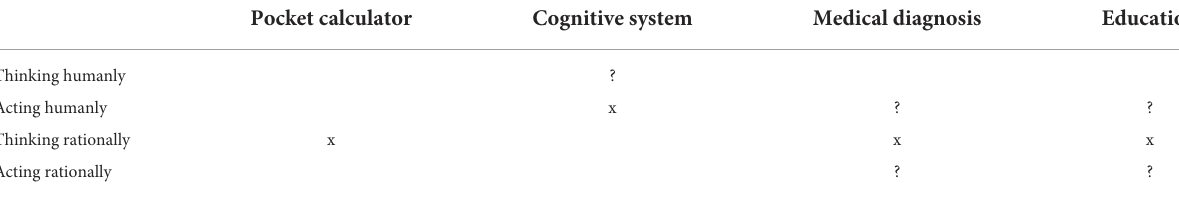
TABLE 1 Which intelligence do Artificial Intelligence systems need? Pocket calculator Cognitive system Medical